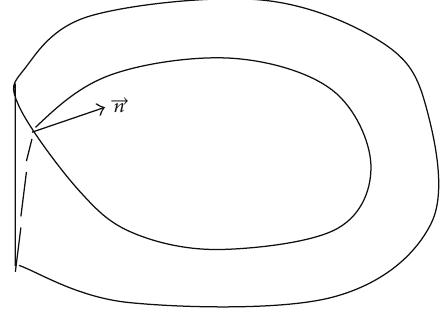
Figure 1: Moebius